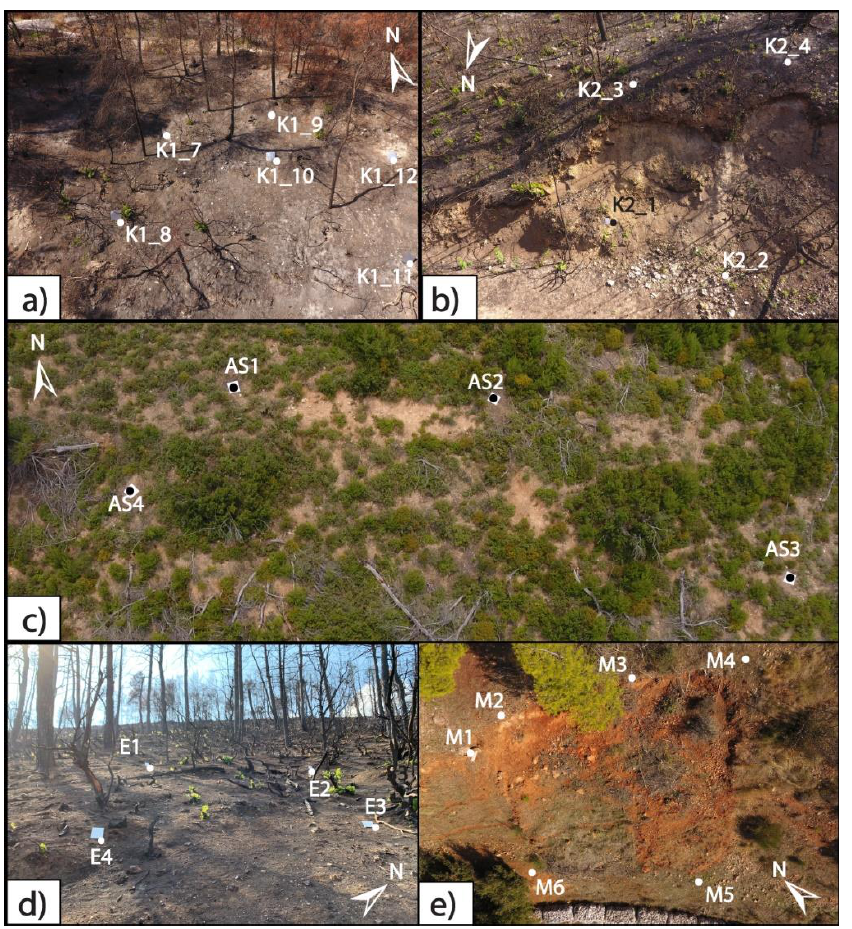
Figure 2. The five selected sites. Black and white dots represent the Ground Control Points (GCP) used for this research. ( a ) Kechries site one (K1_7 – K1_12); and ( b ) Kechries site two (K2_1 – K2_4); ( c ) Agios Stefanos (AS1 – AS4), ( d ) Evia (E1 – E2) (modified from [31] (p.170); and ( e ) Magoula (M1 – M6).